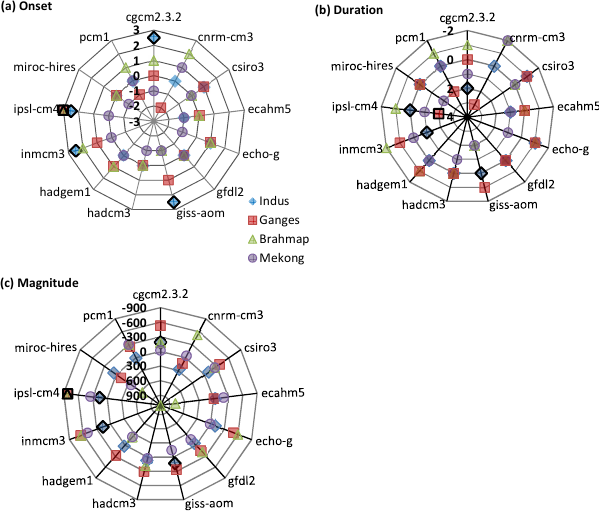
Fig. 6. Difference for the 20th century climate (1961–2000) rel- ative to the observations, (a) monsoon onset timings, (b) mon- soon duration, (c) monsoonal precipitation magnitude. Positive val- ues indicate the delayed onset and prolonged monsoon duration in months and an overestimation of monsoonal precipitation magni- tude in mm, while the negative values indicate the opposite. Note that GCMs which do not simulate the monsoon precipitation regime at all for the particular basin (markers with black border) are only shown for indicative